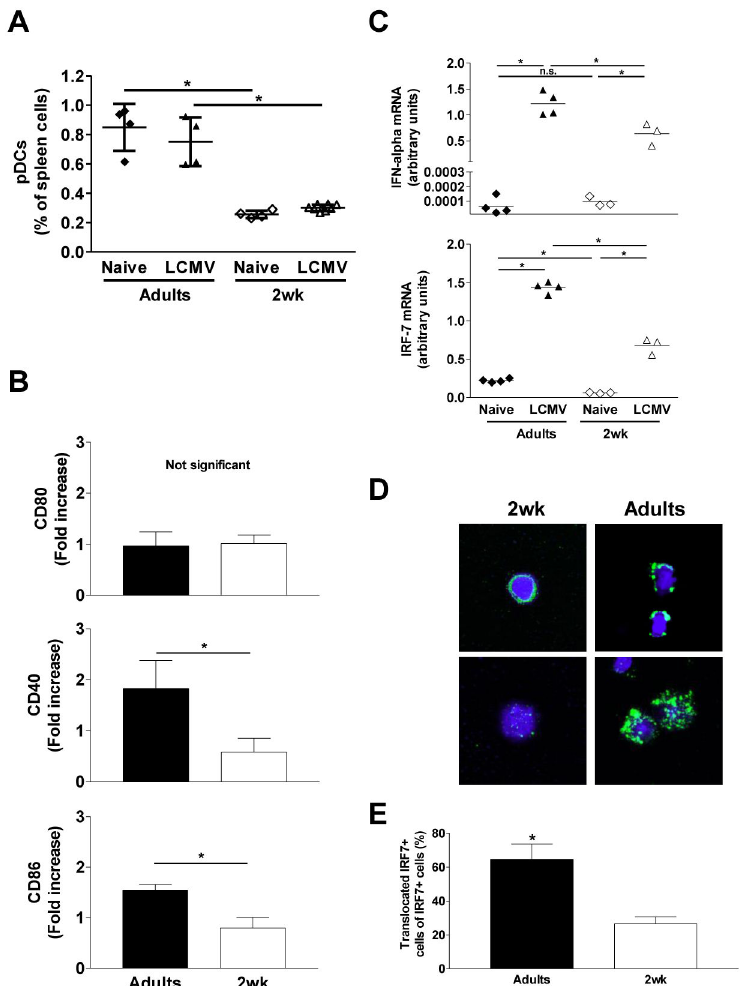
Figure 3. Limited activation and function of pDCs in LCMV-infected 2-week-old mice. (A) Percentages of infant and adult splenic CD11c int Siglec-H + B220 + PDCA-1 + pDCs determined by FACS staining before (naive) and 1 day after LCMV-WE infection (LCMV). One of three representative experiments is shown. *, p <0.05. (B) Fold increase of CD80, CD40 and CD86 expression by infant and adult splenic pDCs, determined by FACS staining between day 0 and day 1 after LCMV-WE infection. *, p <0.05. n = 6 to 8 mice per group. One of two representative experiments is shown. (C) Expression of IFN-α, and IRF-7 mRNAs in sorted pDCs from infant or adult spleens before (naive) and 1 day after LCMV-WE infection (LCMV). *, p <0.05. n = 4 pools of 2 adult mice or 3 pools of 6 to 8 infant mice. One of two representative experiments is shown. (D) Pictures of isolated pDCs from infected infant and adult mice after cytospin, methanol fixation and IRF-7 (green) and DAPI (blue) staining (EC Plan Neofluar 40x 1.3 Oil DIC objective, Zeiss LSM510 Meta confocal microscope). Upper and lower panels showing non-translocated and translocated nuclear IRF-7, respectively. (E) Percentage of IRF-7 + pDCs displaying IRF-7 translocation into the nucleus. *, p<0.05. More than 1000 IRF7 + pDCs (from at least 4 different individual adult or 4 different pools of 6 to 8 infant mice) were counted. One of two representative experiments is